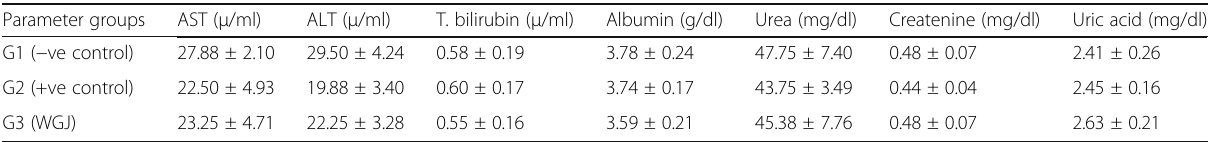
Table 6 Liver and kidney functions in rats ’ experimental animals Parameter groups